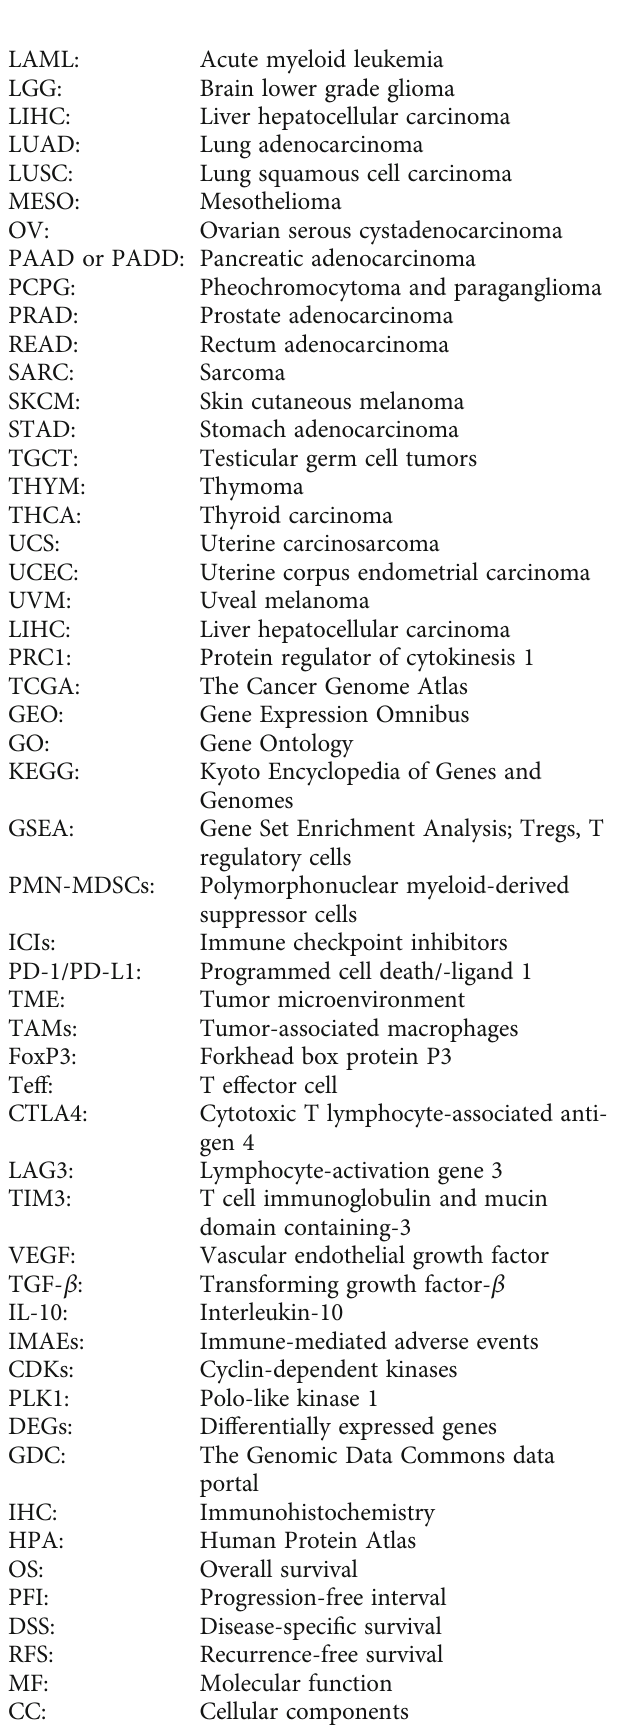
Supplementary Table 1. The sample characteristic statistics of GSE84402 dataset. Supplementary Table 2. The expres- sion of the top 300 PRC1 coexpressed genes in LIHC dataset in TCGA database. Supplementary Figure 1. The pan-cancer prognostic value of PRC1. (Supplementary